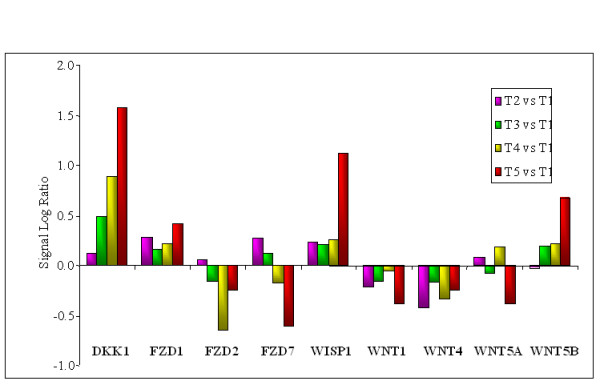
wnt pathway genes identified as being dysregulated in osteoblasts following exposure to dexamethasone. A list of 9 wnt pathway associated genes were identified using KEGG pathway analysis. The Microarray determined expression levels of these genes are represented in the bar chart and demonstrate the temporal regulation patterns of these genes. T1 = control, T2 = 30 mins, T3 = 60 mins, T4 = 120 mins and T5 = 240 mins dexamethasone exposure